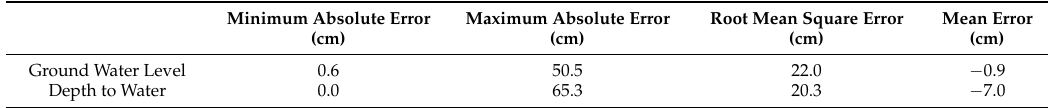
Figure 7. A scatterplot displaying the field measured depth to water (DTW) in x axis and our model generated DTW in y axis. Table 1. Quantitative accuracy statistics for the predicted ground-water level and depth-to-water surfaces, based on 31 temporally coincident well